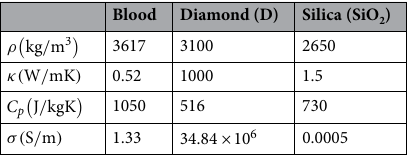
Blood Diamond (D) Silica (SiO 2